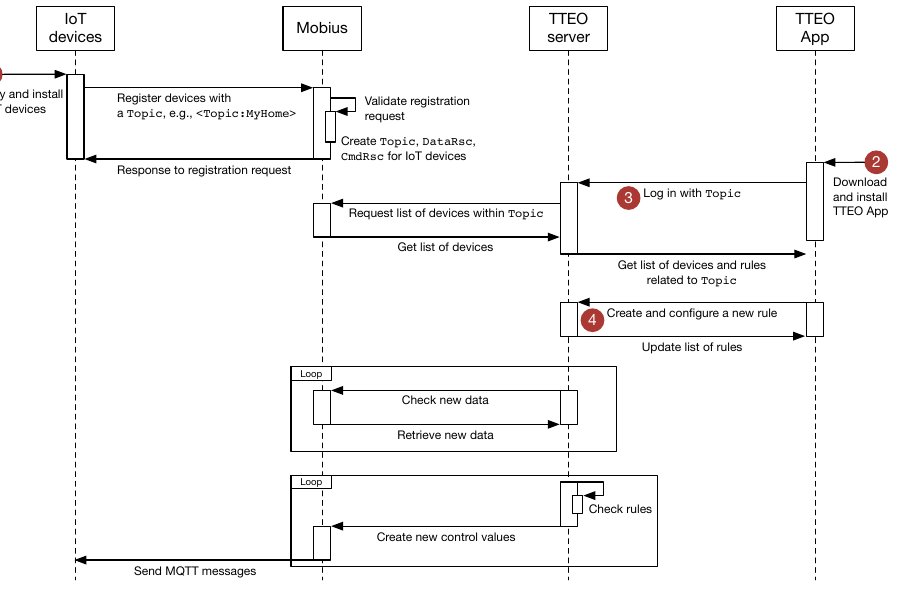
Figure 5. A sequence diagram for operating procedure of TTEO